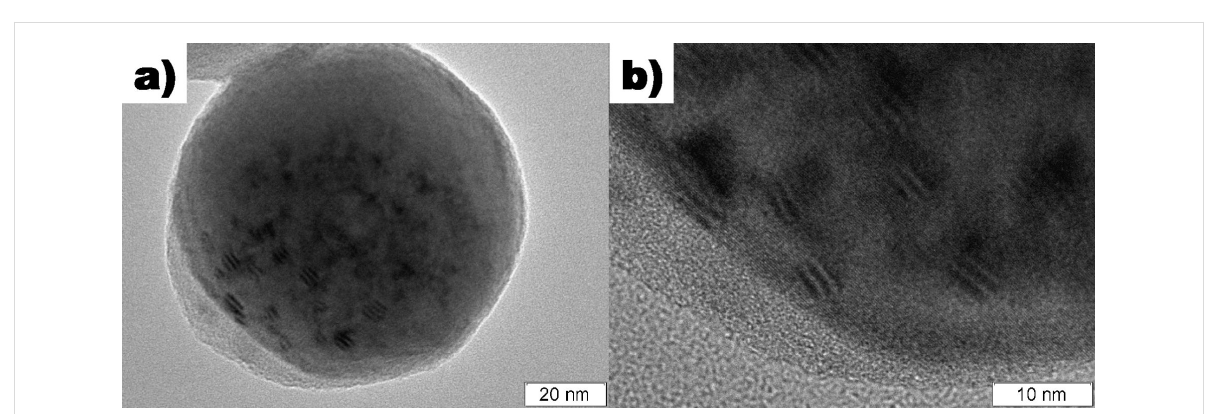
Figure 3: TEM micrograph of a Cu particle with an incomplete shell demonstrating moiré patterns where Cu 2 O has grown on the Cu. a) View of whole particle, b) detail of the moiré patterns.